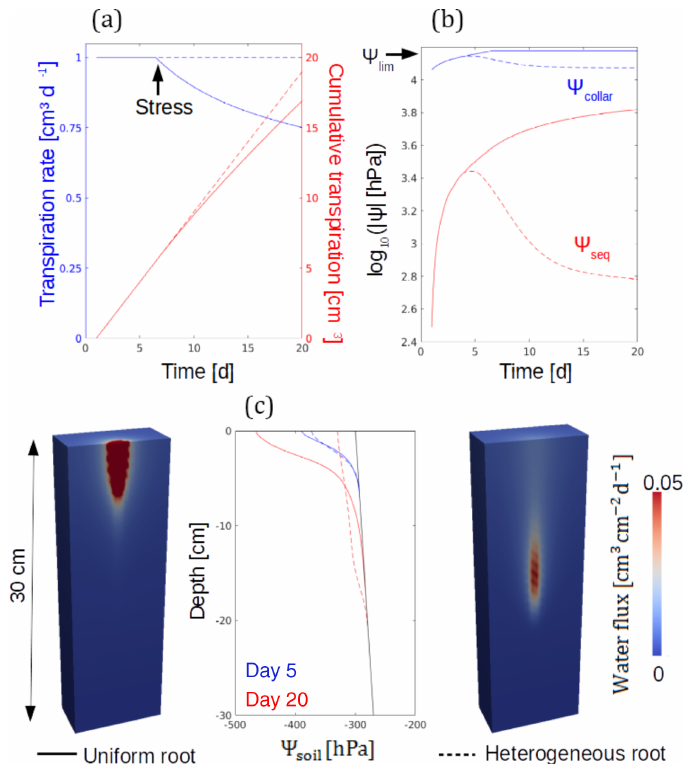
Figure 10. Root performances in a coupled soil–root model: changes of instantaneous and cumulative water uptake (a) and of collar and equivalent potential (b) for a uniform (dashed) and heterogeneous (solid) roots. In (c) , the z -averaged profiles of soil potentials are plotted early and late in the simulation. The resulting water velocities at the end of the simulation are also shown in the clipped domain for both scenarios.